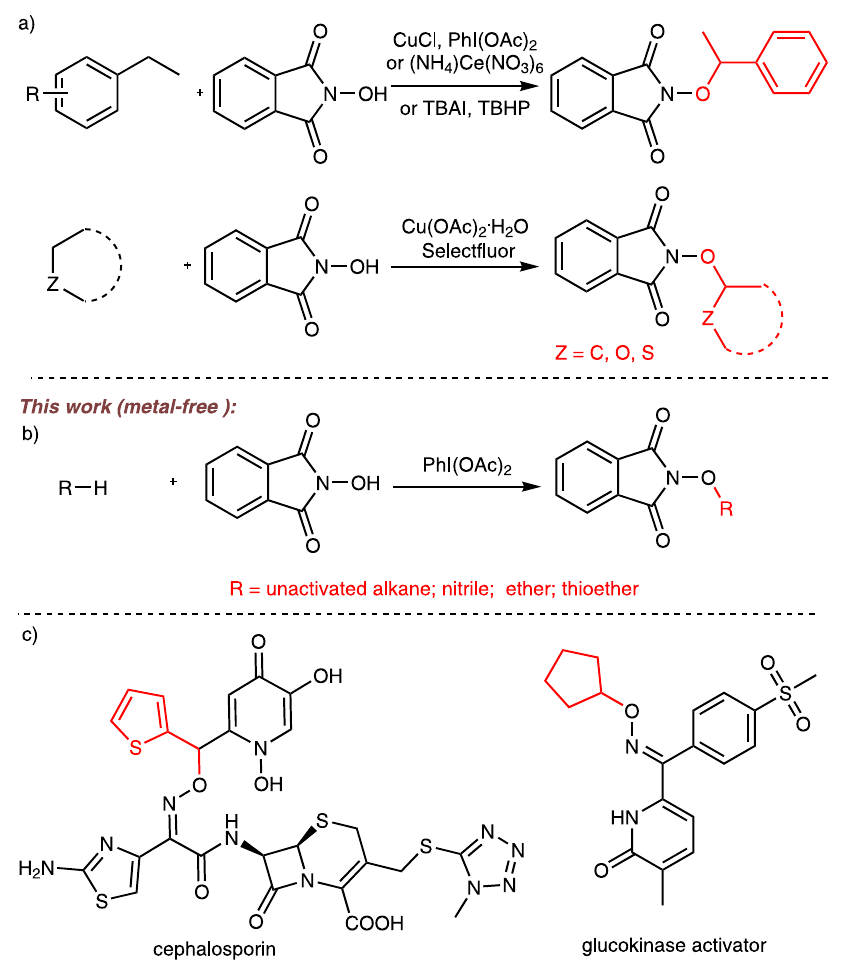
Fig. 1 Cross-dehydrogenative C – O coupling using NHPI. a Approaches for the cross-coupling reactions under transition metal catalyst or tert - butylhydroperoxide. b Cross-dehydrogenative C – O coupling reaction of N-hydroxyphthalimide with unactivated C(sp 3 ) – H by using iodobenzene diacetate. c Structures of cephalosporin and glucokinase